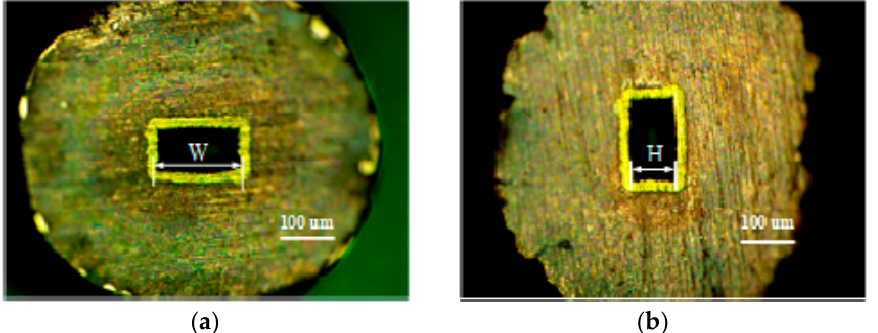
Figure 12. Measurement examples of waveguide cavity end-face size: ( a ) Leica example of end-face width, ( b ) Leica example of end-face height.